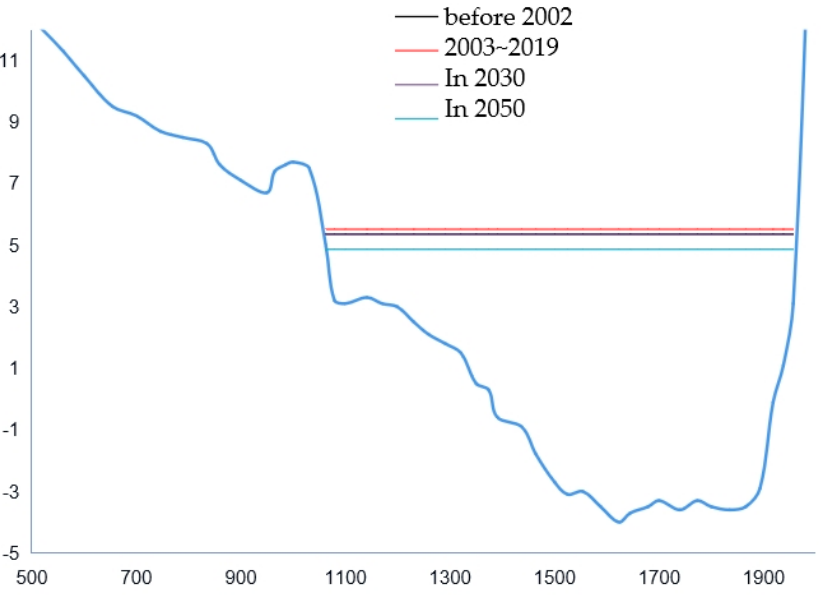
Figure 16. Analysis of the navigable depth (WL with 98% guaranteed rate) at the Hukou section.